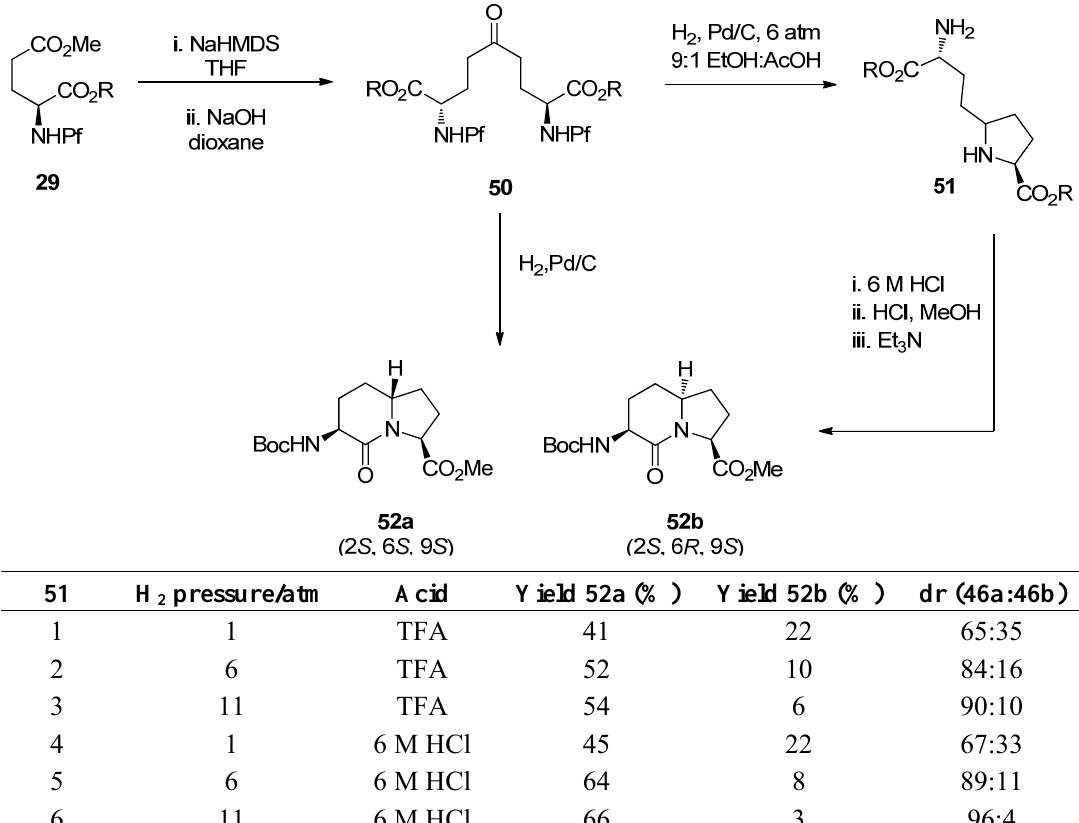
Table 8. The effect of hydrogen pressure and the acid on the diastereomeric ration in reductive